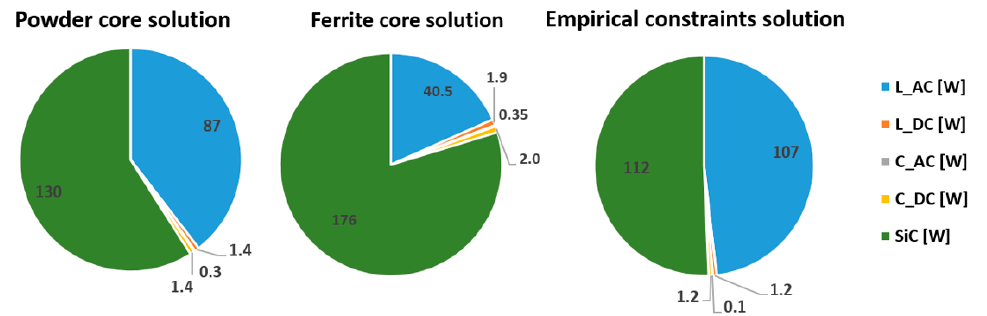
Figure 11. Optimal loss repartition for the three solutions at 97.8% efficiency.